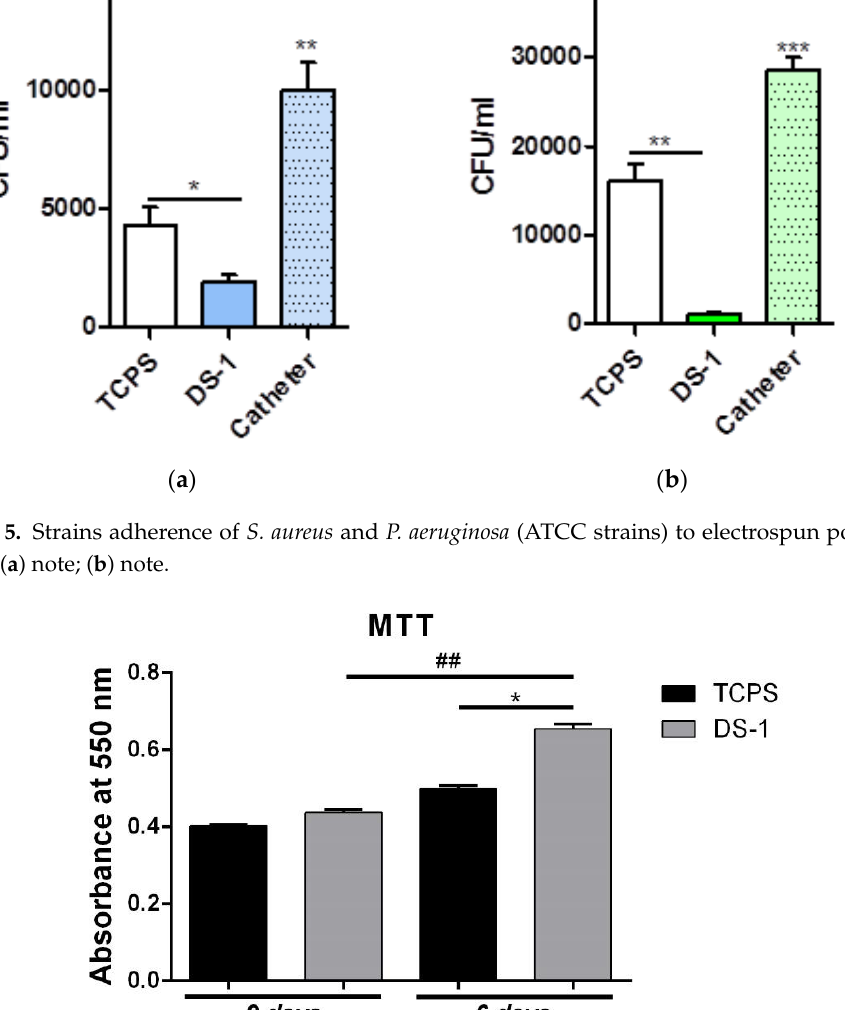
Figure 5. Strains adherence of S. aureus and P. aeruginosa (ATCC strains) to electrospun polyimide fibers. ( a ) note; ( b ) note.